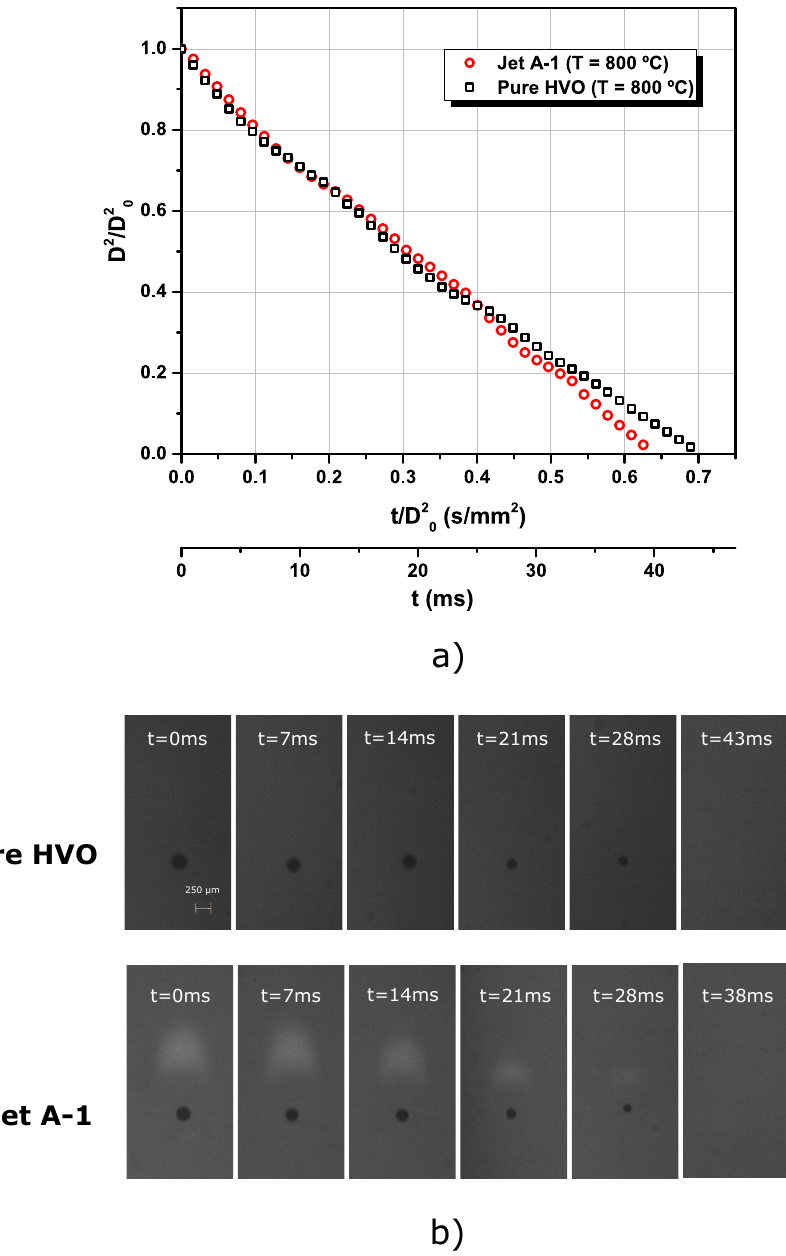
Figure 8. Jet A-1 and HVO combustion at T = 800 ◦ C: ( a ) Droplet size evolution; ( b ) Sequence of imagens of burning